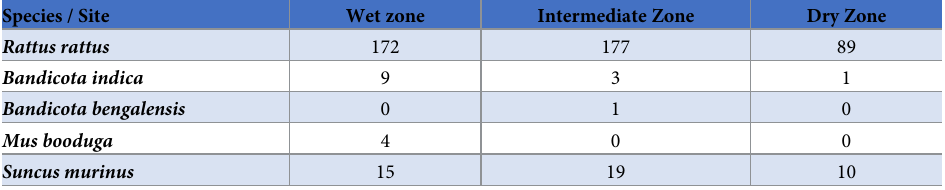
Table 1. Individuals per species per climate zone. In the dry zone, trapping effort was only half that of the trapping effort in the intermediate and wet zone.